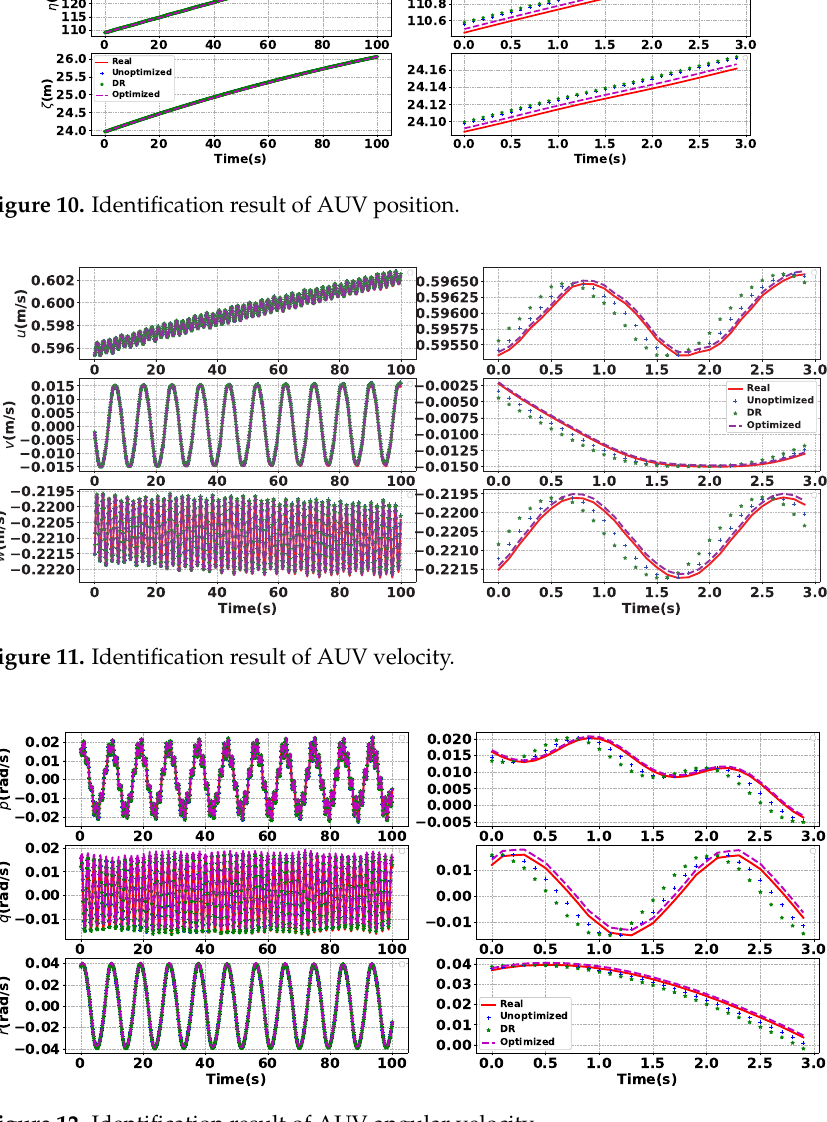
Figure 12. Identification result of AUV angular